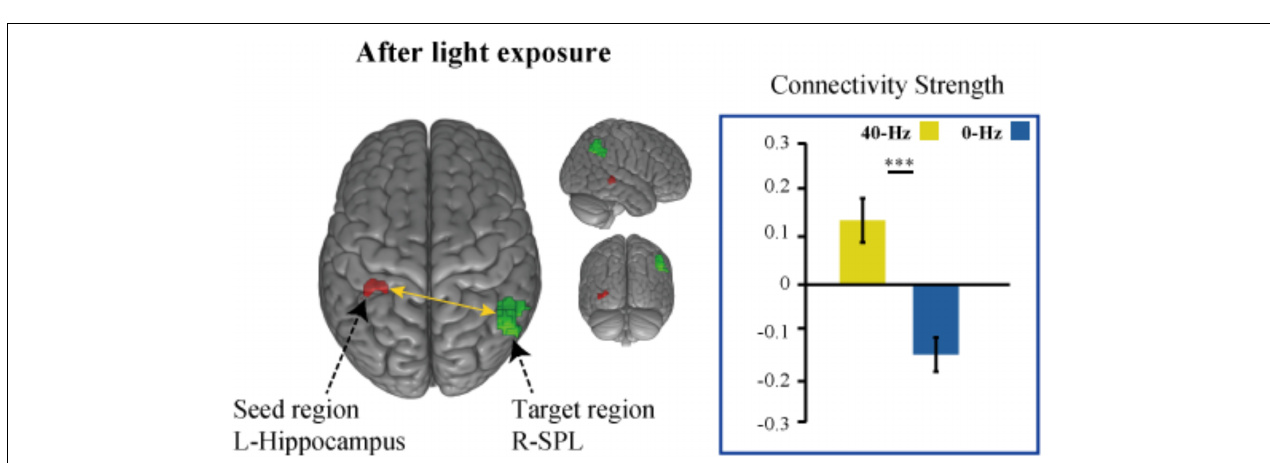
FIGURE 5 | (A) Intergroup differences in functional connectivity of the left hippocampus seed during the memory judgment task after the optical stimulation. (B) Scatter plots of the correlation between functional connectivity strength (hippocampus with the bilateral MTG) and score of the digital span test. ∗ P < 0.05, ∗∗∗ P < 0.001.